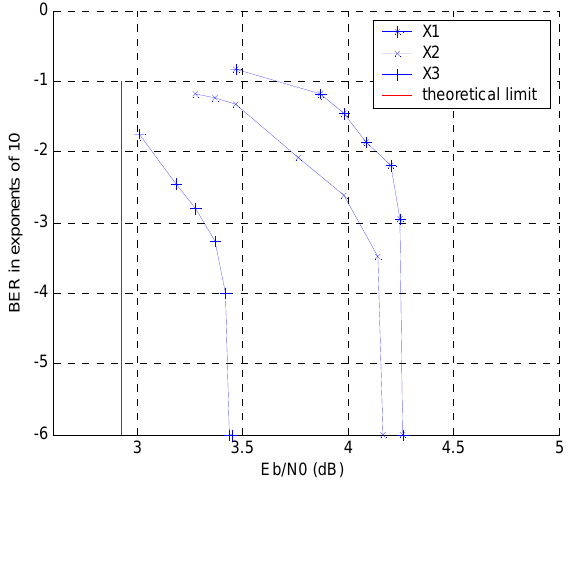
, X and X in the symmetric-rate 1 2 3